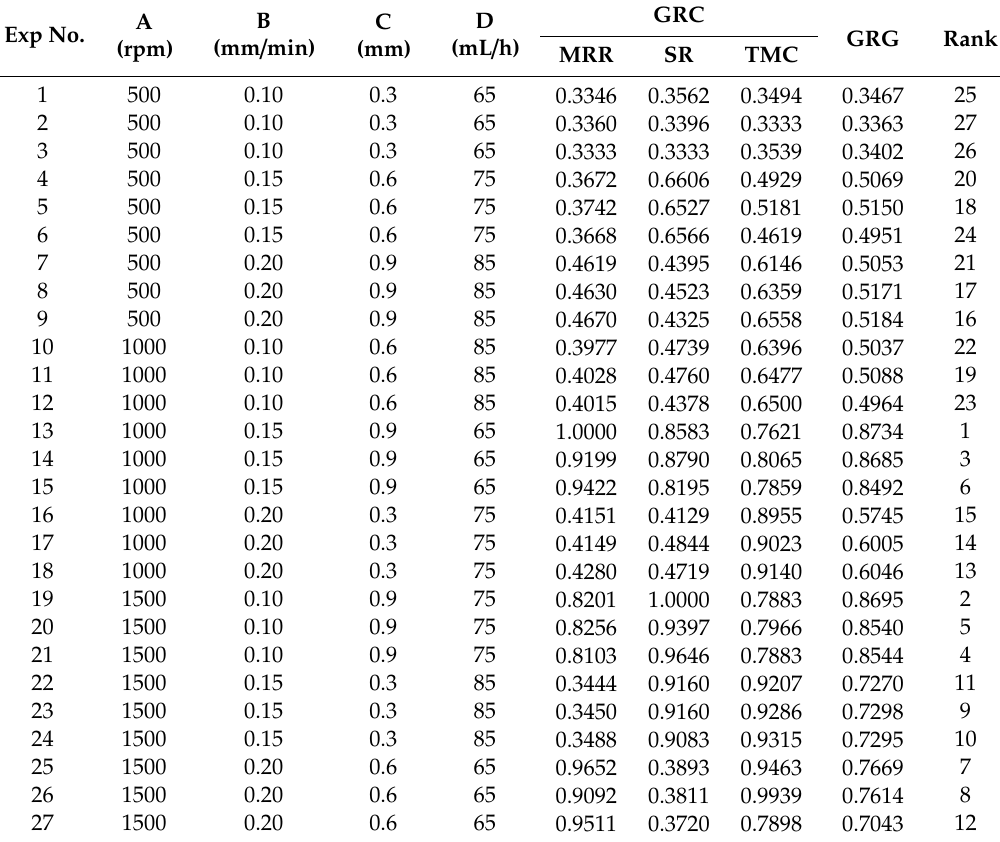
Table 8. Multi-aspects optimization outcomes by Grey Relational Analysis